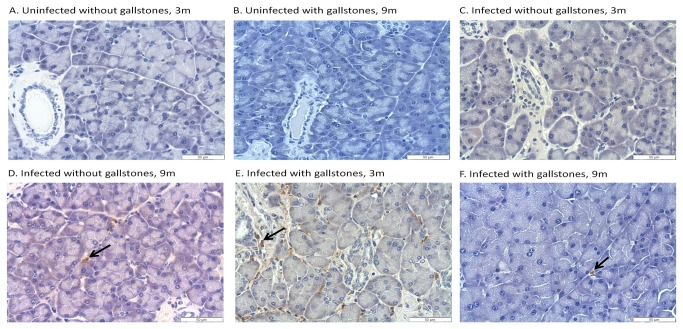

Salmonella LPS staining was detected in the exocrine pancreas regardless of the presence of gallstones.Representative IHC images of mouse pancreas sections at 3 and 9 months post-infection using an anti-Salmonella LPS antibody. Salmonella was detected in the interstitium around acini or ductular cells (Panels D, E and F). DAB and hematoxylin counterstain. 40x.